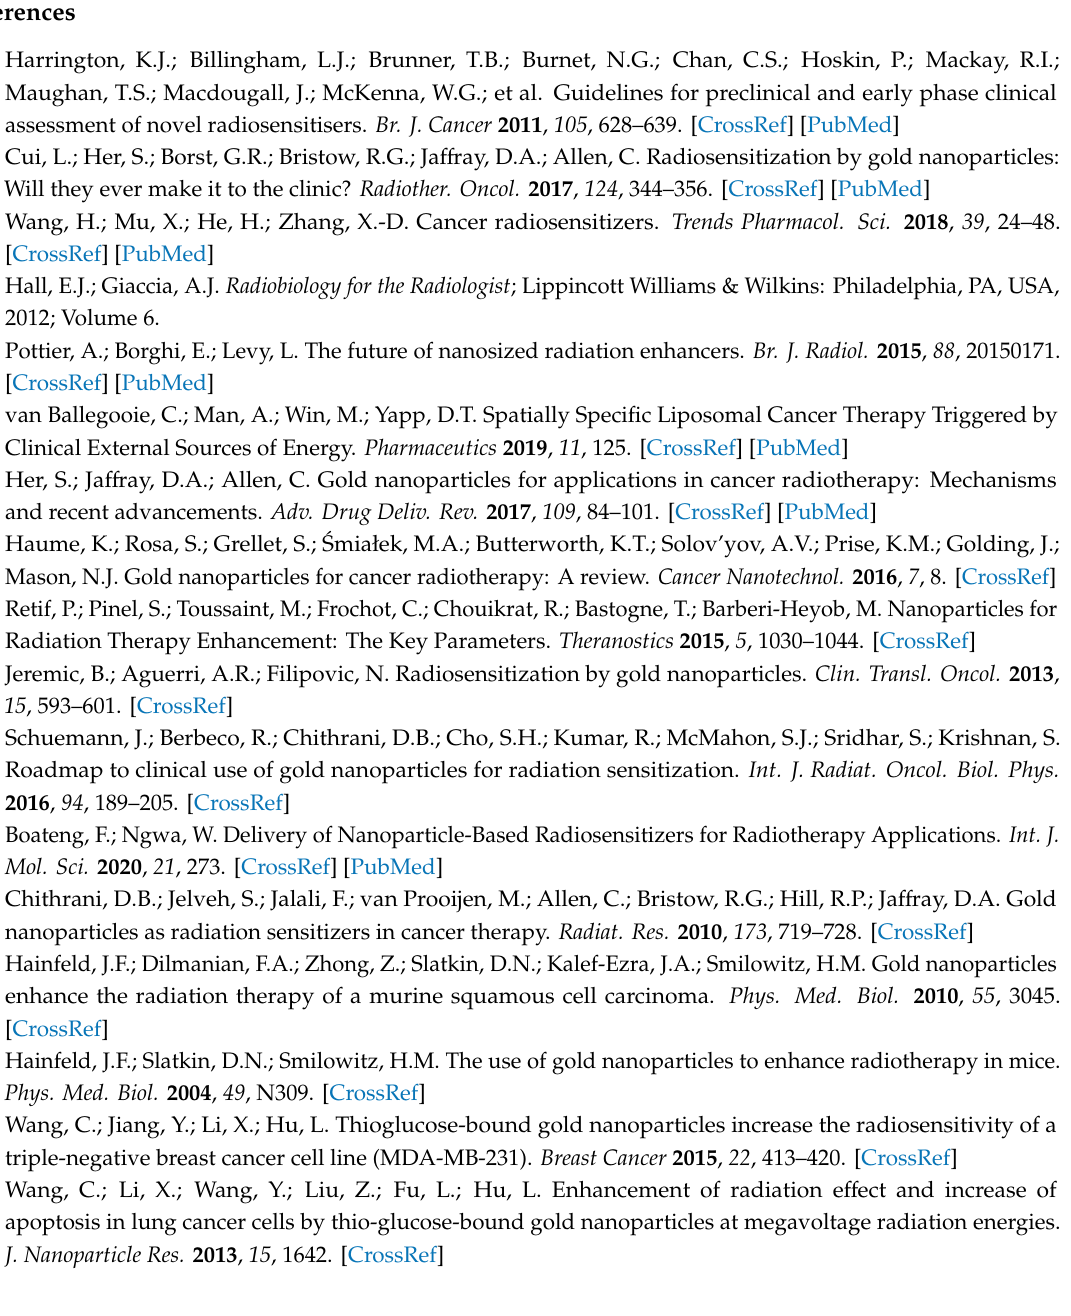
Figure S1: Setup for in vitro irradiation, Figure S2: Flow cytometry of avidin-labeled VEGFR2-AuMBs, Figure S3: VEGFR2-AuMBs bonded to human umbilical endothelial cells (HUVEC), Figure S4: Setup for in vivo